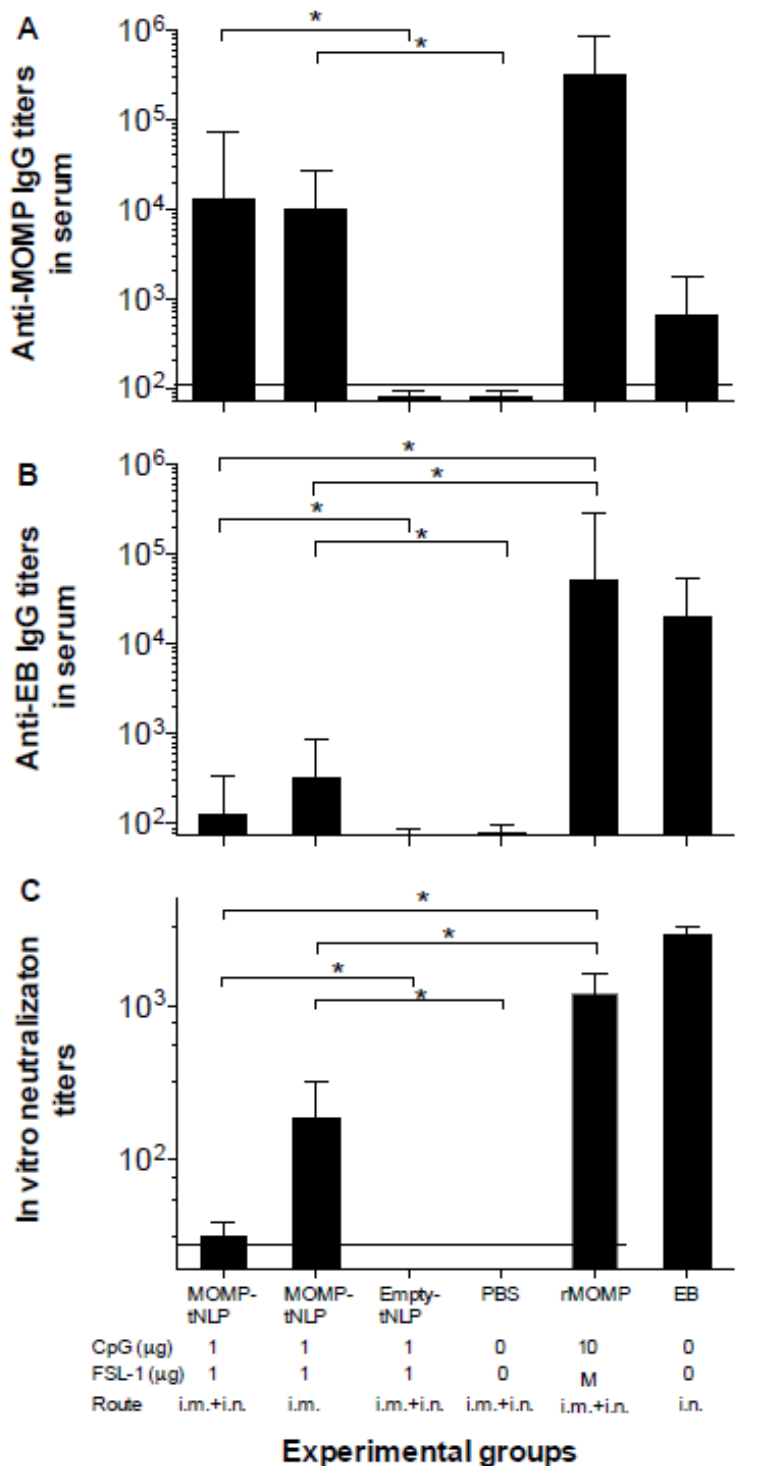
Figure 2. Serum antibody titers. ( A ) Anti- C. muridarum MOMP and ( B ) anti- C. muridarum EB IgG antibody titers. ( C ) In vitro neutralizing C. muridarum EB titers. Serum samples were collected before immunization as background control, and antibody titers were determined the day before the i.n. challenge. Horizontal dotted lines represent the limit of detection. * p < 0.05 by ANOVA.